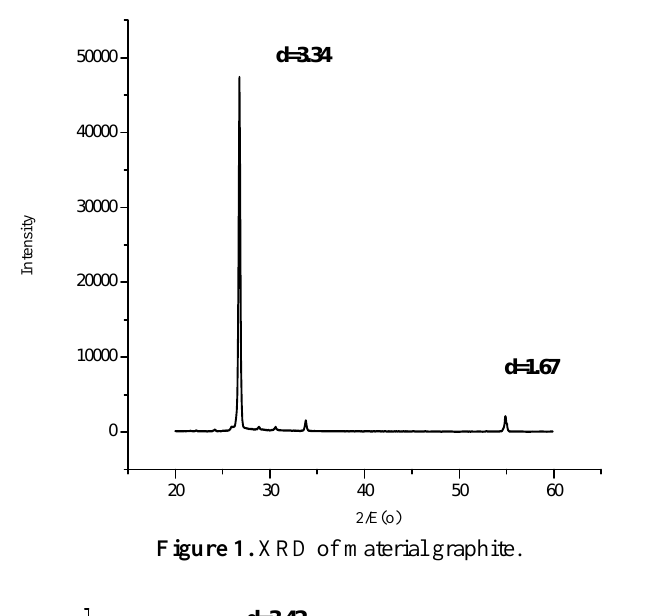
Figure 1. XRD of material graphite.